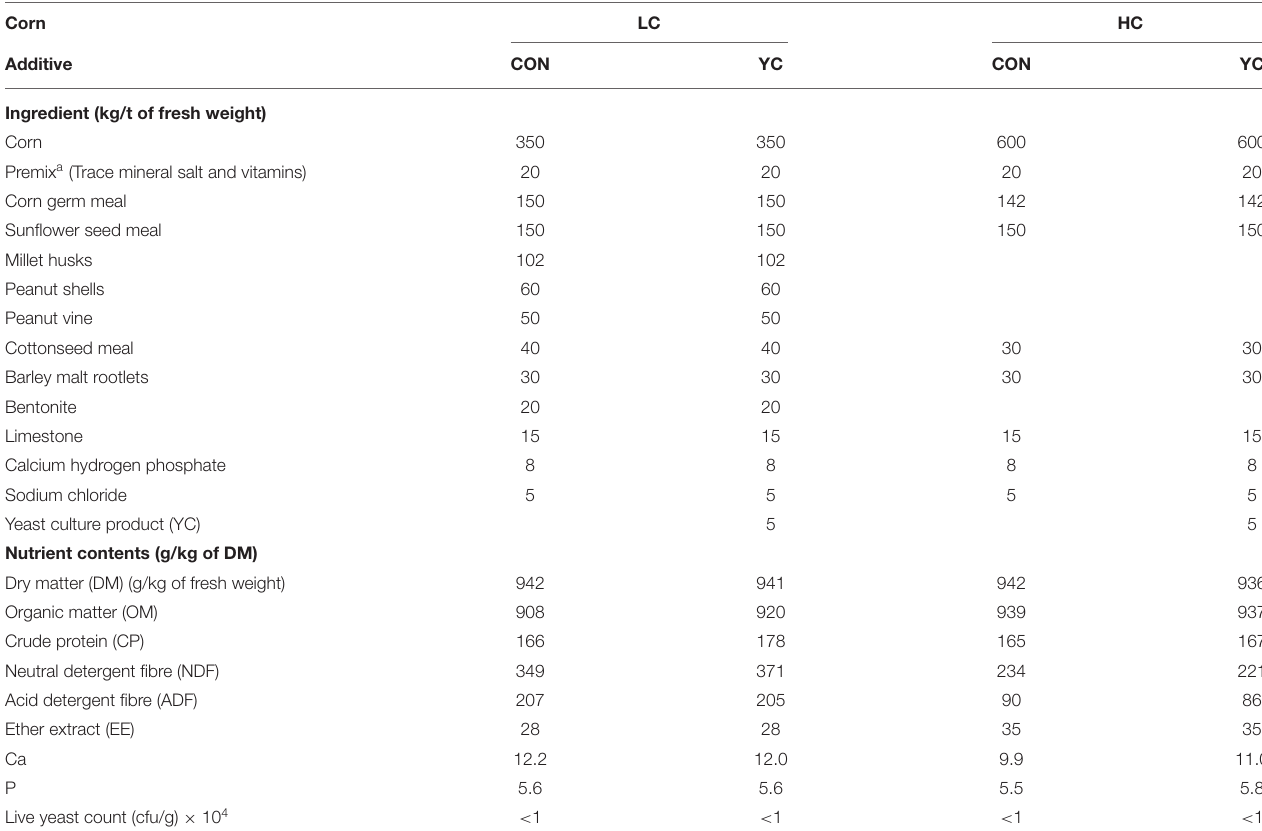
TABLE 1 | Ingredients and nutrient contents of experimental diets containing a low (LC) or high (HC) proportion of corn and supplemented with nil (CON) or yeast culture (YC). Corn LC HC Additive CON YC Ingredient (kg/t of fresh weight) Corn Premix a (Trace mineral salt and